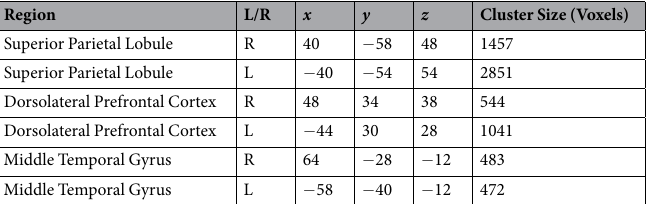
Table 1. Out-group/In-group > (Identical In-group, Different In-group): Repetition Suppression. Coordinates refer to peak voxel in Montreal Neurological Institute stereotaxic